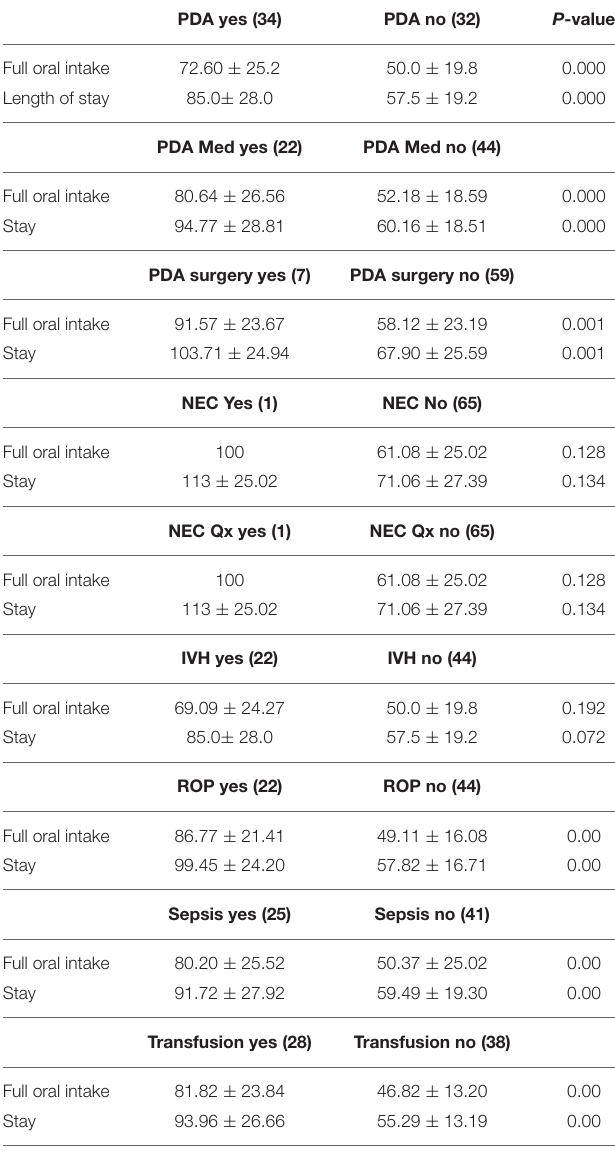
TABLE 3 | Associations between Pretermassociated morbidities and age at full oral feeding and age at